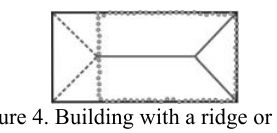
Figure 4. Building with a ridge or hips.